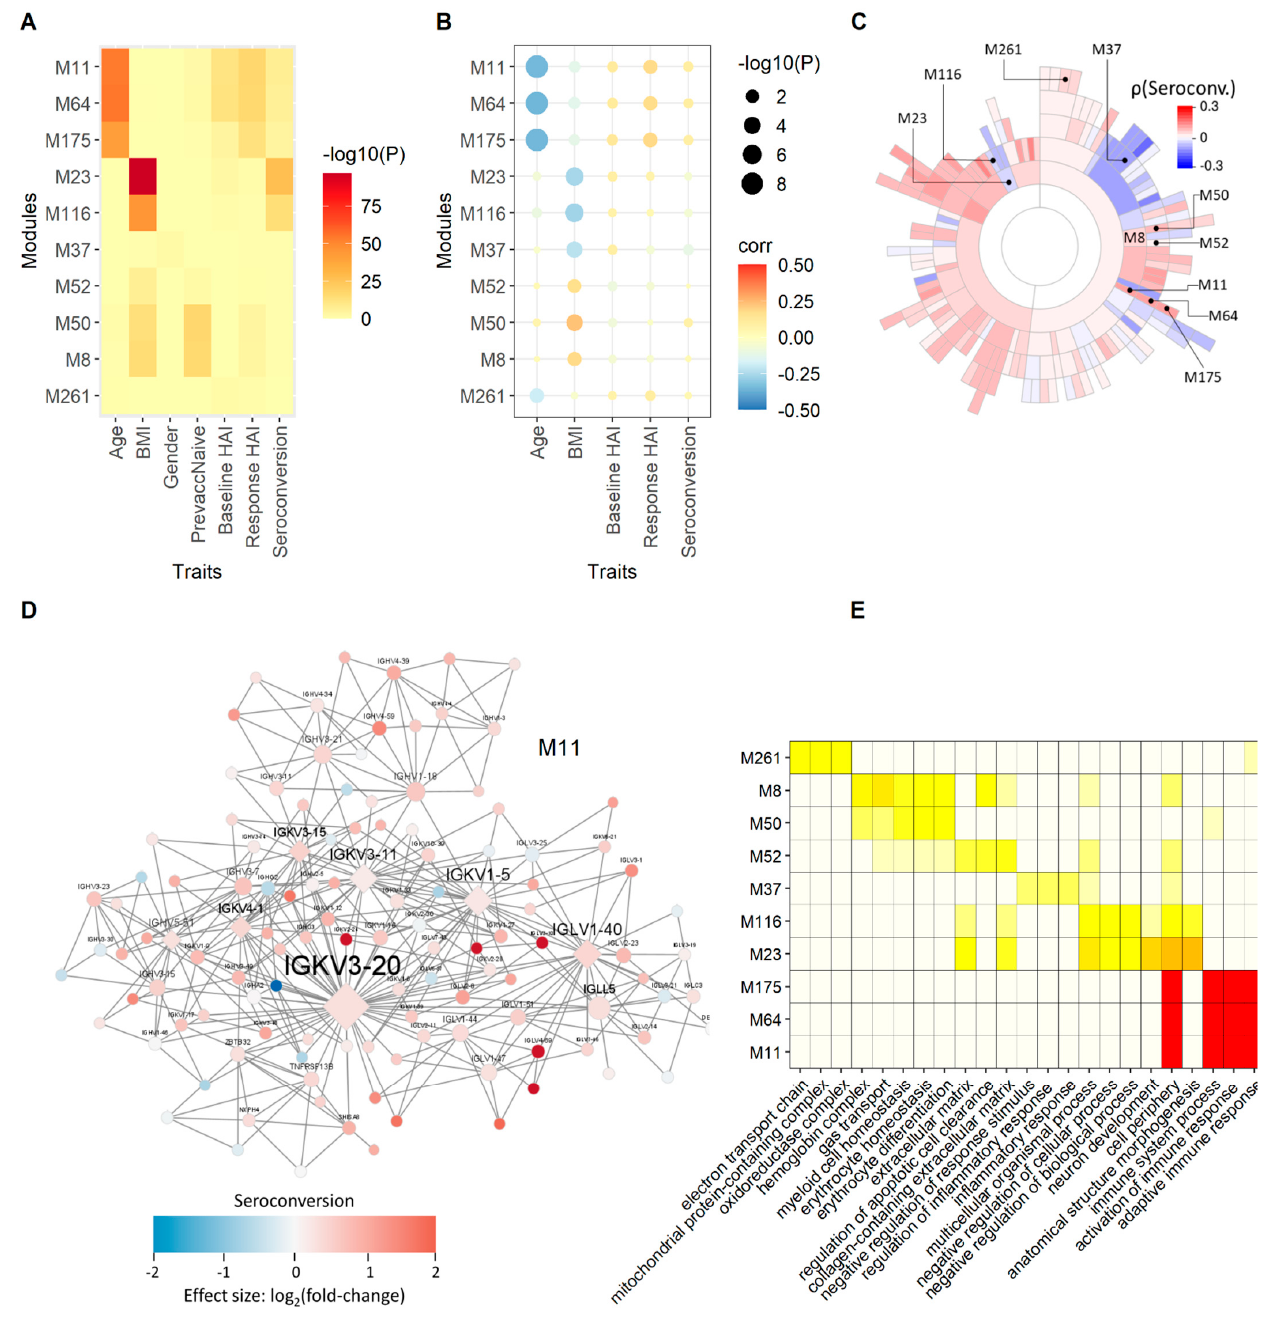
Figure 4. Multi-scale co-expression network analysis. Using MEGENA we defined gene co-expression network modules associated with participant metrics and immune status. The 10 best ranked modules are shown using a combined rank based on the correlations related to serological effects and outcome (average baseline, average seroconversion and average response). ( A ) The module enrichment for DEGs are depicted in this heatmap. ( B ) The dot-plot shows the correlation coefficients and corresponding p -value of module/trait correlations. ( C ) A sunburst plot with the hierarchical structure of the module. ( D ) Module M387 enriched for immunoglobulin functionality. Node colors indicate fold change with respect to high versus low average seroconversion, red for increased expression in subjects with high seroconversion compared to subjects with low seroconversion, blue refers to decreased gene expression between these two groups of subjects. ( E ) The functional enrichment of the corresponding modules for GO functions are shown. The hierarchical relationship of the modules shown in ( A , B ) are as follows: M8 → M50/M52; M11 → M64 → M175; M23 →